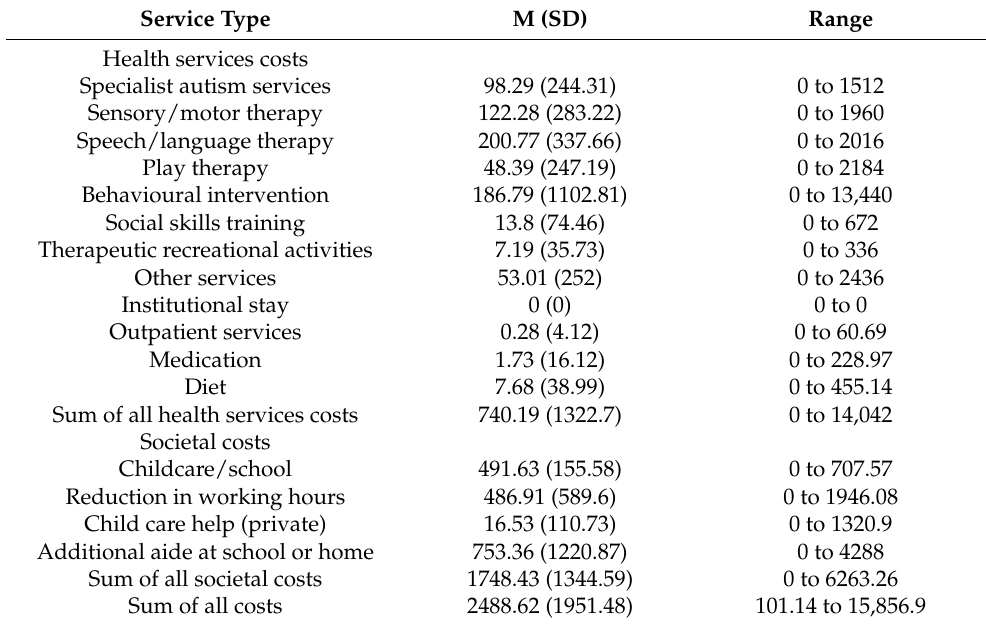
Table 6. Health services and societal costs received by 217 children with ASD in